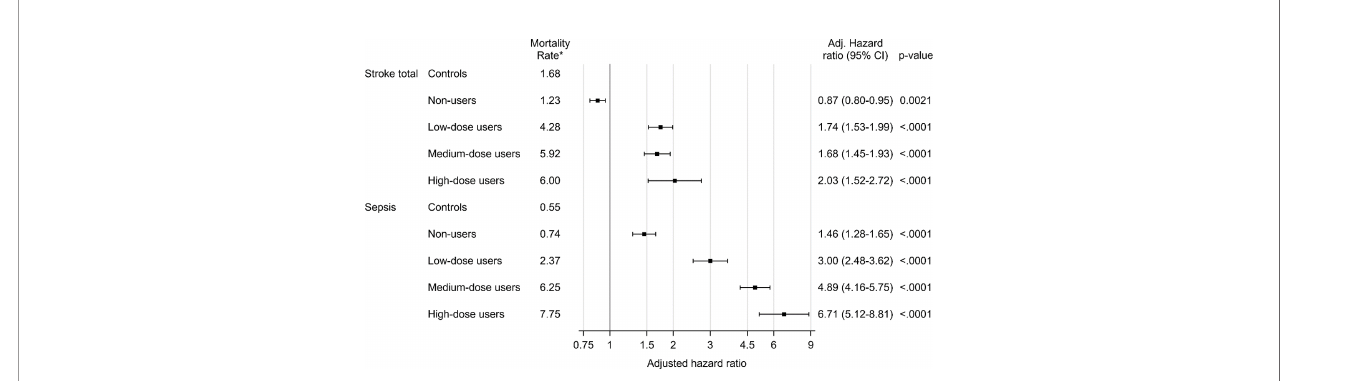
FIGURE 2 | Mortality due to stroke and sepsis in glucocorticoid users compared to age- and sex-matched controls. Mortality analysis was performed for controls and for non-users (0 DDD per day), low-dose users (more than 0 DDD per day but lower than 0.5 DDD per day), medium-dose users (0.5-1.5 DDD per day) and high-dose users (more than 1.5 DDD per day). Time-dependent Cox proportional hazard models was used. The hazard ratio was adjusted for age, sex and comorbidities (diabetes, deep vein thrombosis, pulmonary embolism, hypertension, stroke, ischemic heart disease, heart failure, pneumonia, malignant neoplasm). *Number of deaths per 1000 patient